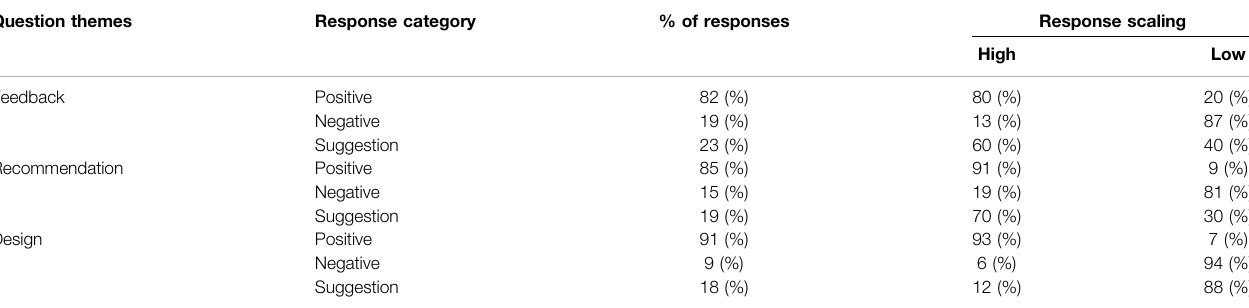
TABLE 6 | Summary of participants ’ responses from real educational setting